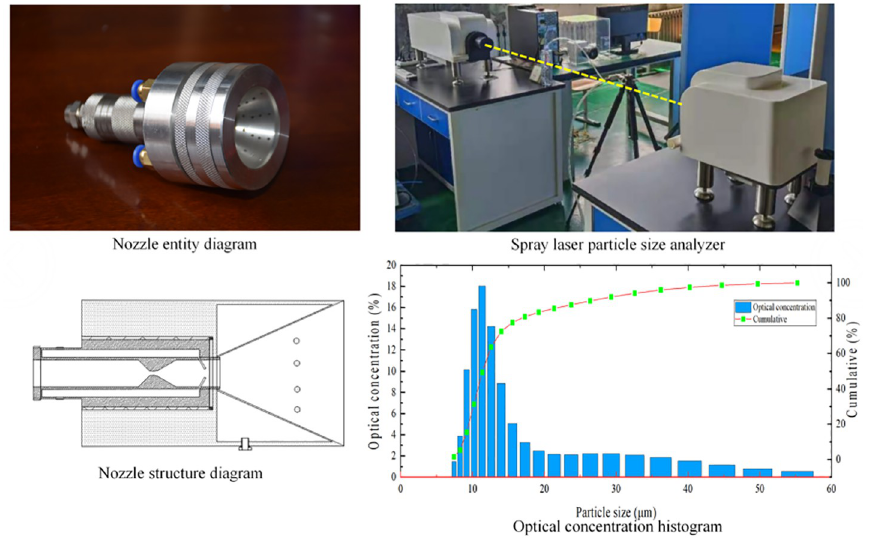
Fig 5. Structure diagram of pneumatic spiral